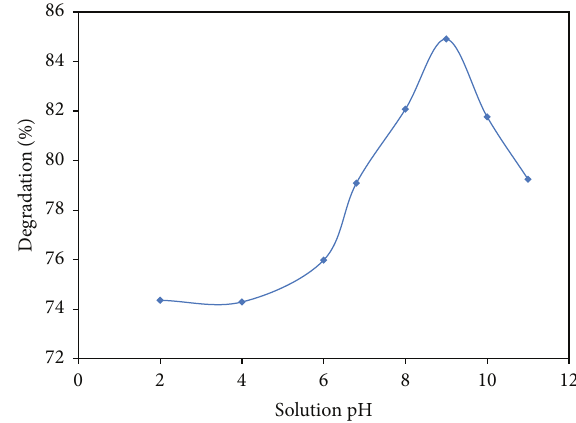
Figure 8: Effect of catalyst dosage on degradation % (Conc.: 50 mgL −1 , pH: 6.8, and intensity: 500 W).